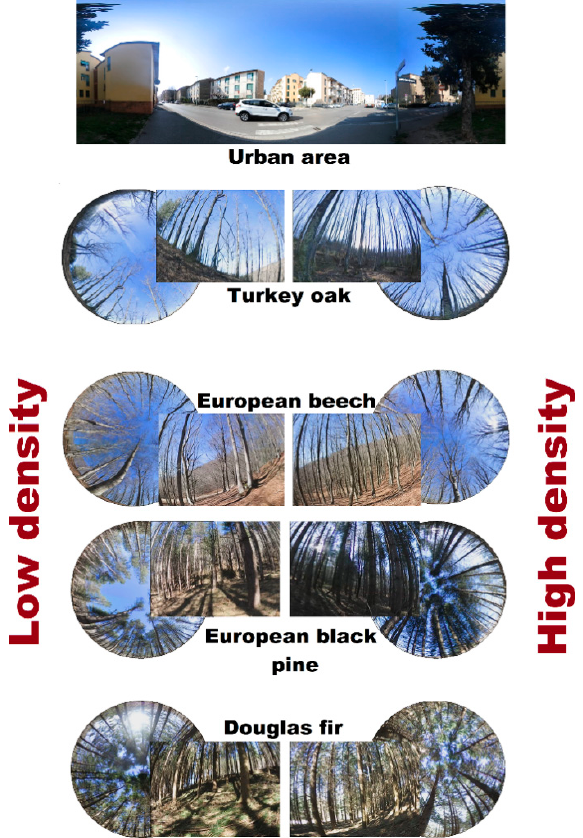
Figure 1. Screenshot from the applied VR video.